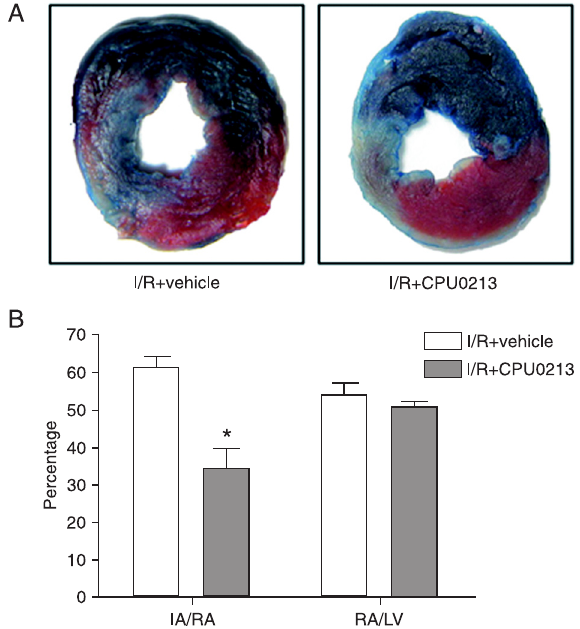
Figure 2. Gross pathology of ischemic hearts. A , Representa- tive mid-myocardial cross-sections of triphenyltetrazolium chlo- ride (TTC)/Evans blue-stained hearts (blue-stained area: non- ischemic tissue; the remaining area: risk area; red-stained area: ischemic area; white area: infarct area. B , RA/LV and IA/RA ra- tios. RA = risk area; IA = infarct area; LV = left ventricle. Data are reported as means ± SEM for 5 rats/group. *P < 0.05 vs I/R + vehicle (unpaired Student t